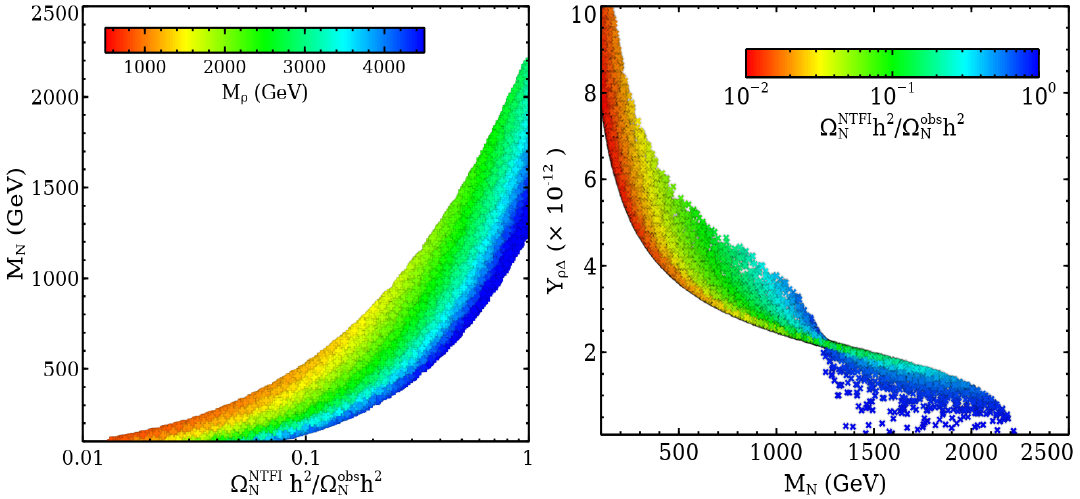
Figure 15 . Left panel: scatter plot in DM mass M N and ratio of contribution from non-thermal freeze-in to the observed DM relic density Ω NTFI h 2 / Ω obs h 2 plane which signifies the required N N variation of the NLOP mass M in order to satisfy the correct DM relic density. Right panel: we ρ show the variation of Ω NTFI h 2 / Ω obs h 2 as scatter plot in Y ρ ∆ − M N N N